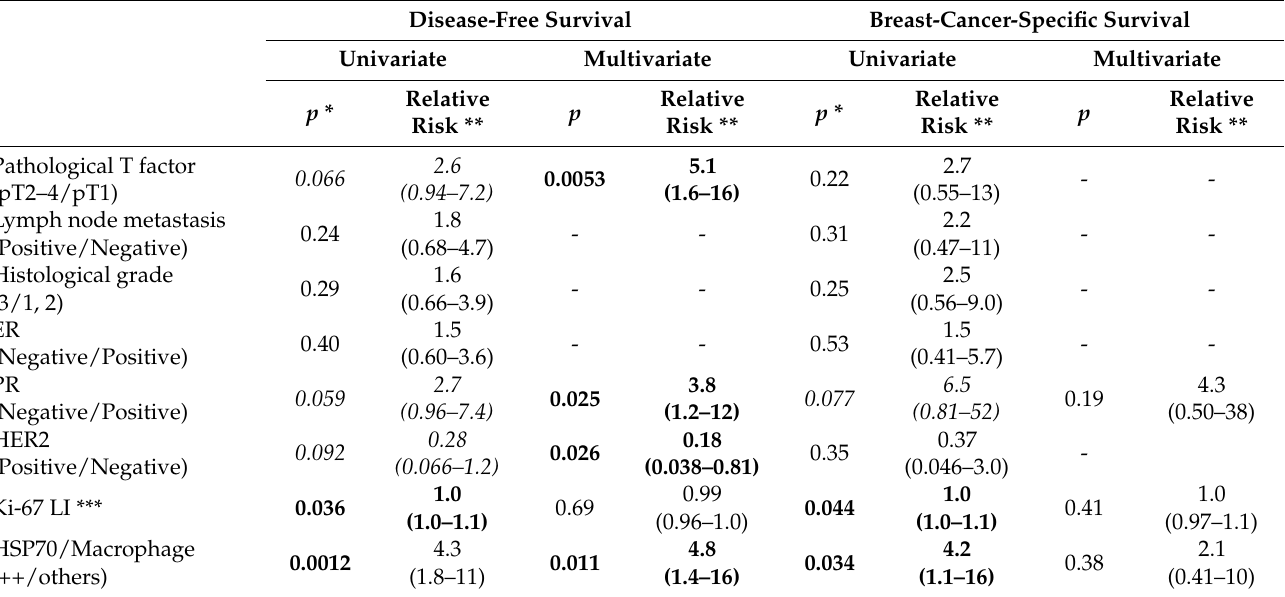
Table 3. Summary of univariate and multivariate analyses of clinical outcomes in 59 breast carcinoma patients who had received adjuvant